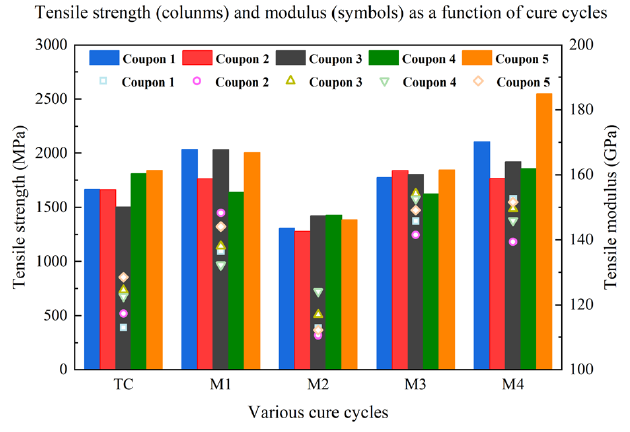
Figure 8. Longitudinal tensile strength and modulus of samples cured by various cure cycles.